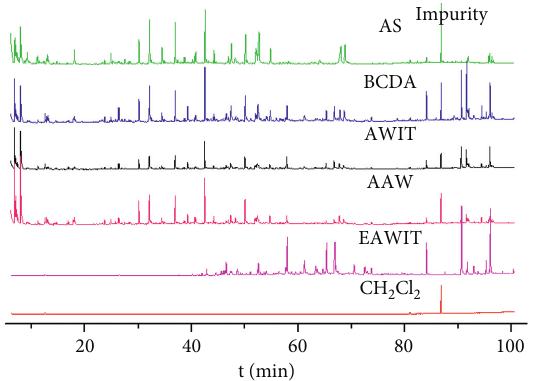
Figure 1: Gas chromatograph mass spectrometry (GC-MS) chromatograms of incense smoke (AWIT: whole-tree agarwood- inducing technique, AAW: agarwood produced by axe wounds, BCDA: burning-chisel-drilling agarwood, EAWIT: extract of stick from agarwood produced by whole-tree agarwood-inducing technique, AS: A. sinensis